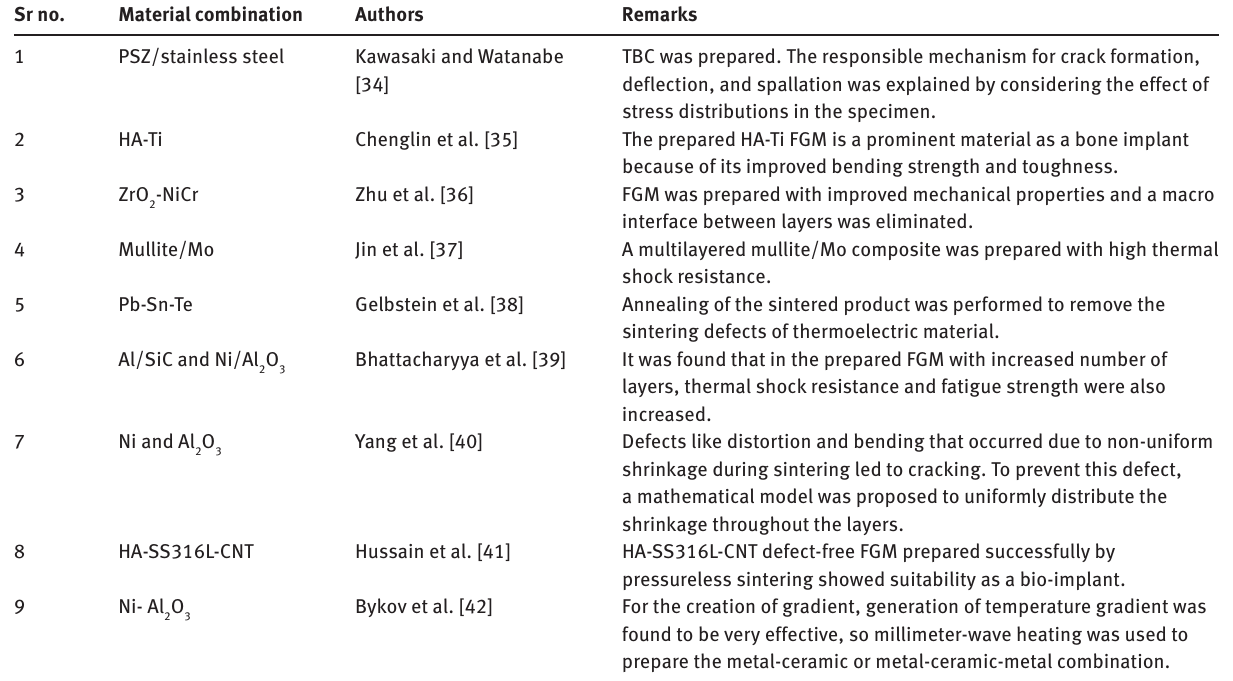
Table 3: List of different authors who used powder metallurgy for fabrication of FGM. Sr no.